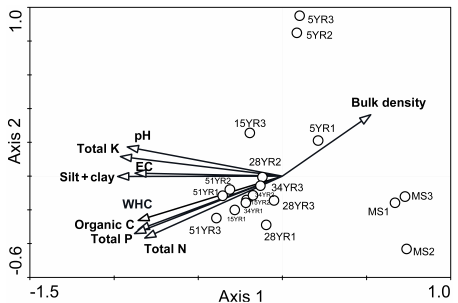
Figure 9. Redundancy analysis (RDA) of bacterial community structures in relation to soil physiochemical properties. Arrows indi- cate the direction and magnitude of soil physiochemical index asso- ciated with bacterial community structures. The lengths of arrows in the RDA plot correspond to the strength of the correlation between variables and community structure. Each circle represents the bac- terial community structure for each